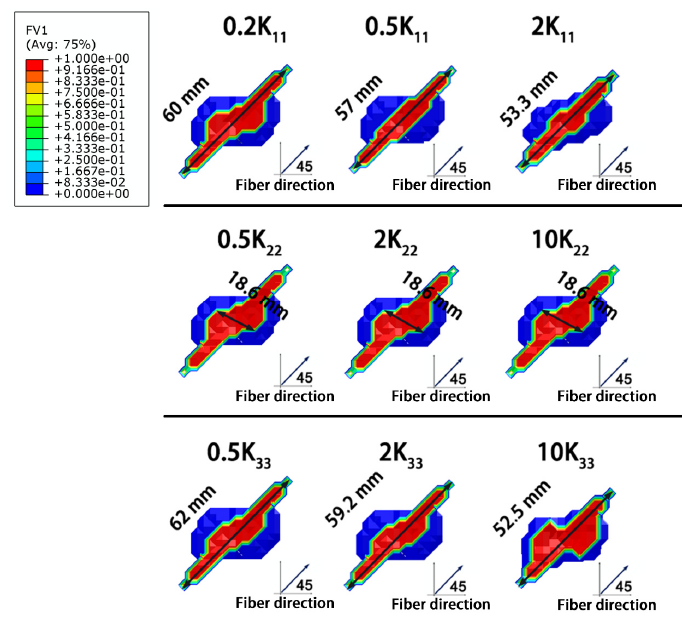
Figure 15. Morphologies of the lightning damage to composites with varying thermal conductivities.